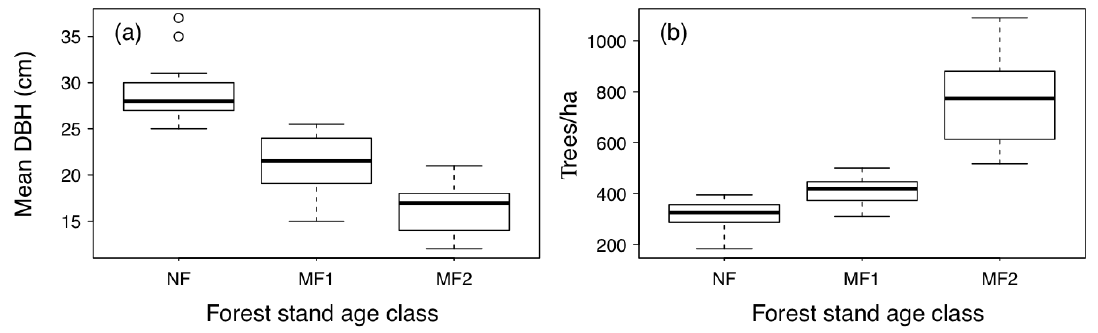
Figure 2. The distribution of ( a ) mean DBH and ( b ) number of trees per ha for the field plots located in three different forest stand age